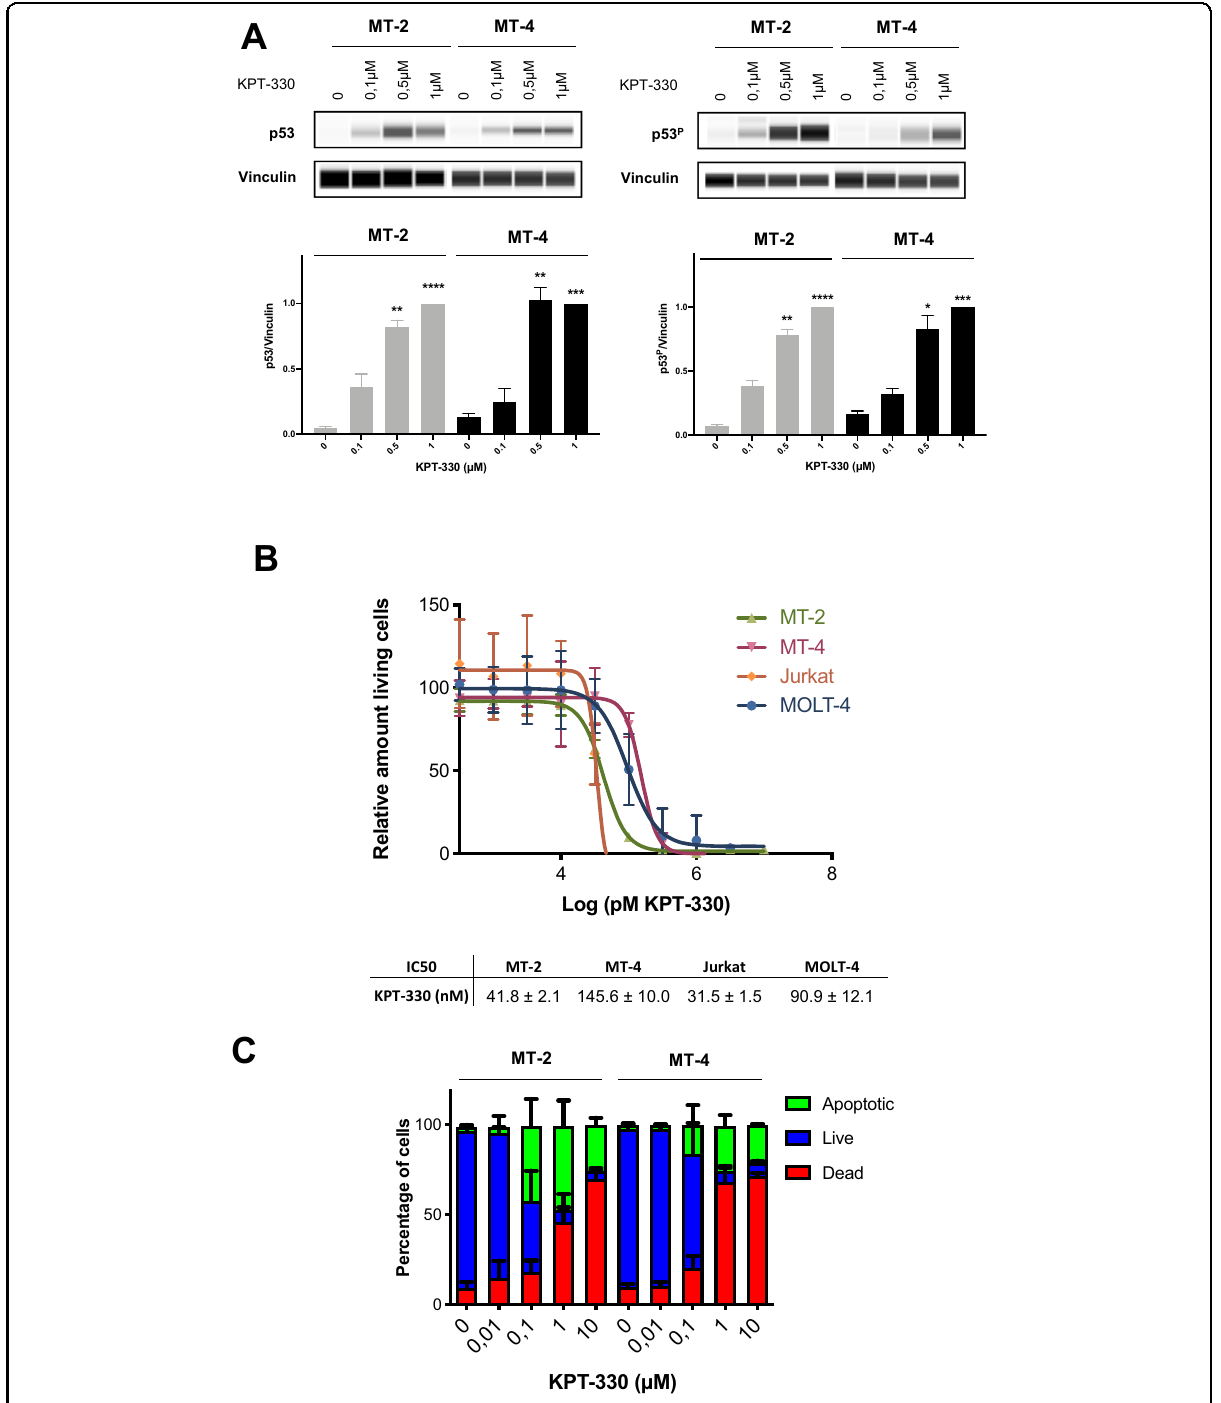
Fig. 2 Pharmacological inhibition of XPO1 induces cell death, p53 upregulation/phosphorylation, and caspase-dependent apoptosis, in HTLV-1-transformed cell lines. A Simple western analysis for p53 and phosphorylated p53 was performed on whole-cell lysates after overnight incubation of MT-2 or MT-4 cells with different concentrations of KPT-330. The graphs show mean of p53 and phosphorylated p53 expression relative to vinculin expression with SEM ( n = 4). Data are normalized to 1 µM KPT-330 within each separate experiment. RM one-way ANOVA, with Geisser- Greenhouse correction. * p = 0.0332; ** p = 0.0021, *** p = 0.0002, and **** p < 0.0001. B Cell viability relative to untreated control as determined by MTT of HTLV-1 transformed cell lines in the presence of different concentrations KPT-330. Error bars represent standard error of mean ( n = 3). C MT-2 or MT-4 cells were treated with DMSO or different concentrations of KPT-330 and after 3 days analyzed by Annexin V/PI fl ow cytometry. Error bars represent standard error of mean (SEM) ( n =